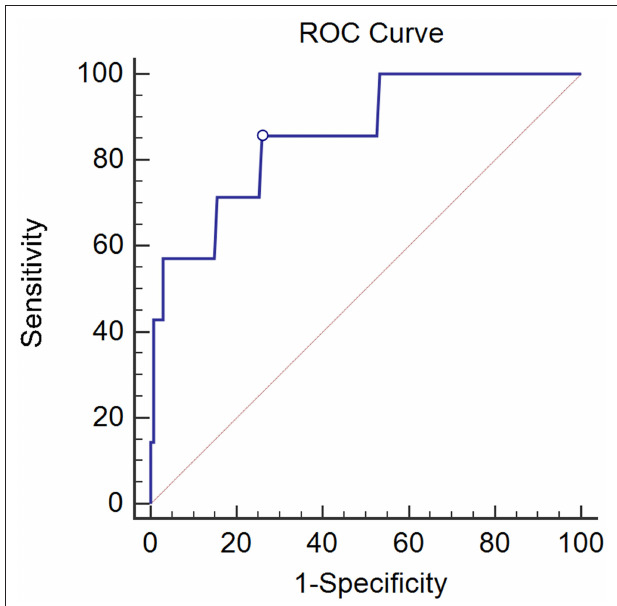
FIGURE 1 | The AUC of CK19 predicting ovarian metastasis in pre-menopausal patients with Type I cancer ( n = 142). AUC = 0.860, 95% CI 0.792–0.912, p < 0.001.